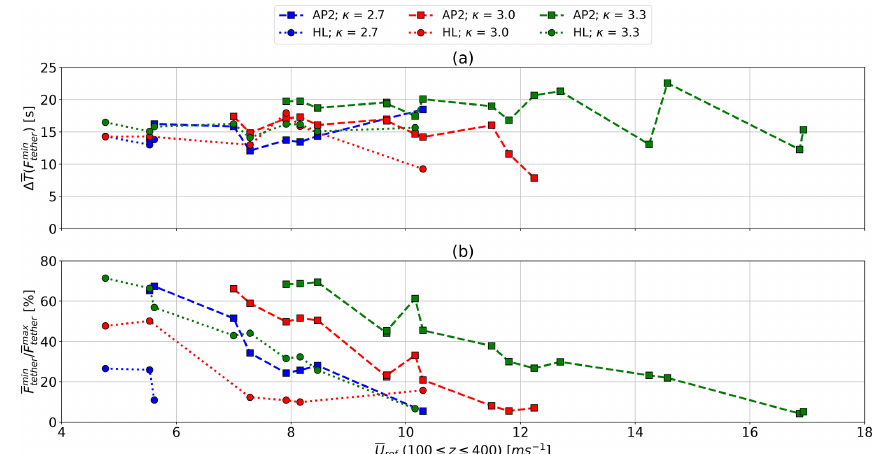
Figure 7. Average time (cid:49)T between tether tension troughs (a) and relative decrease in tether tension (b) during the production phase of optimized ground-generation AWESs with a wing area of A = 50m 2 . The diagram show results for mass-scaling exponents κ = 2 . 7, 3.0, 3.3 (blue, red, green) and both sets of aerodynamic coefficients, AP2 reference (square, dashed line) and high lift – HL (circle, dashed